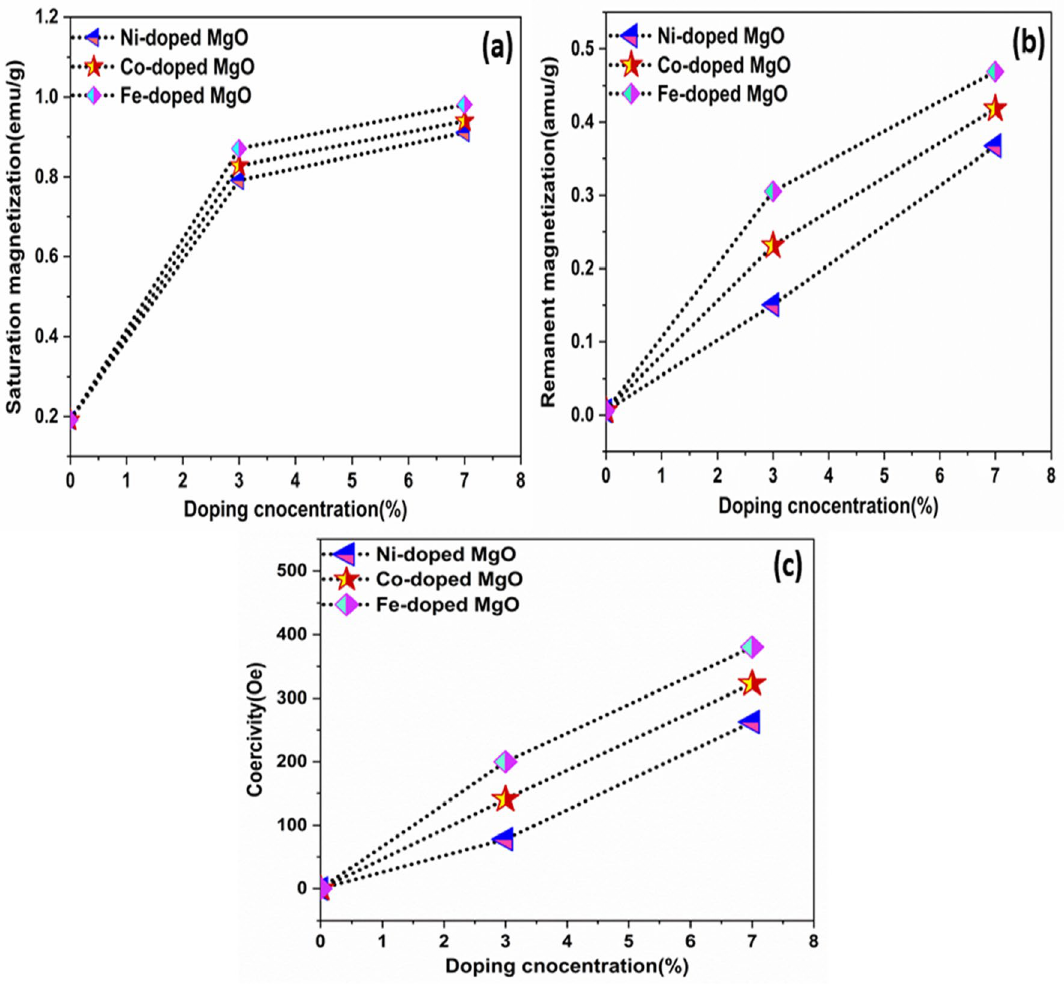
Figure 14. The correlation between the doping concentration and ( a ) Ms, ( b ) Mr, ( c ) Hc for Ni , Co , and Fe-doped MgO nanoparticles with the various doping concentrations of 0%, 3% and